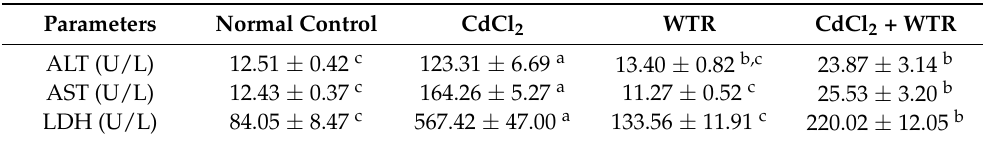
Table 2. Effects of the waste of Taif rose extract (WTR) on liver function levels in serum of cadmium chloride (CdCl 2 )-intoxicated male rats versus normal rats.